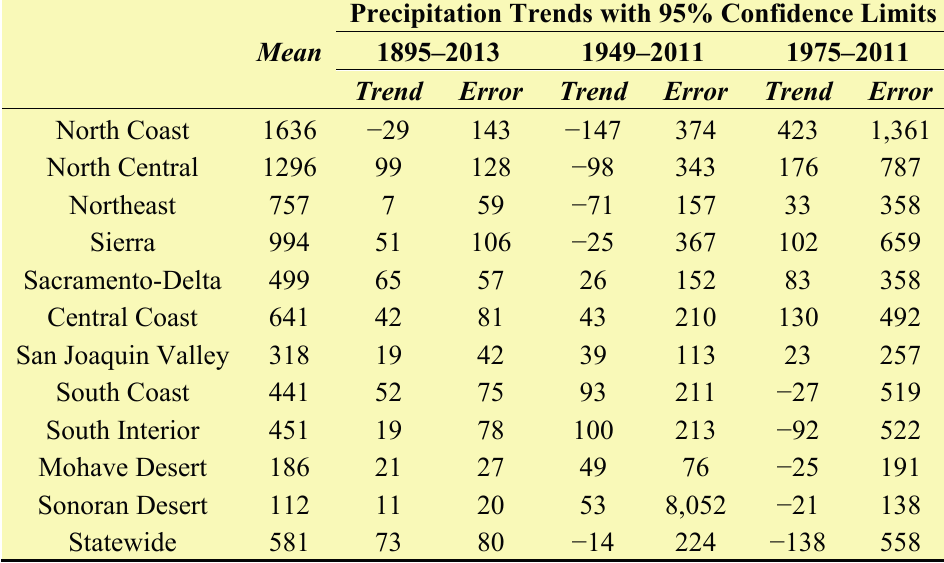
Table 2. Winter rainfall trends over different periods based on the eleven California climatic regions in mm per 100 years. Values in blue represent significant